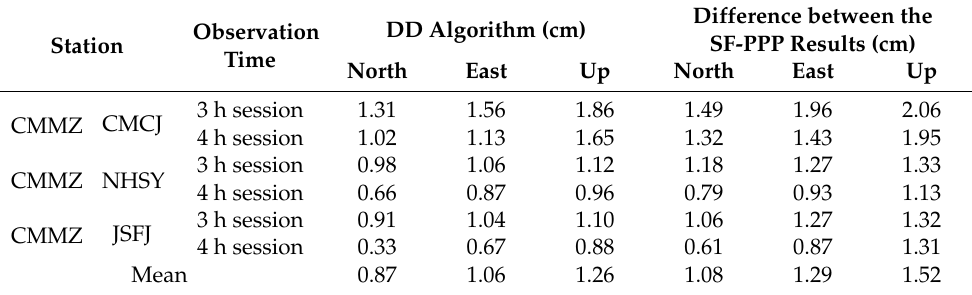
Table 3. Relative positioning accuracy of two